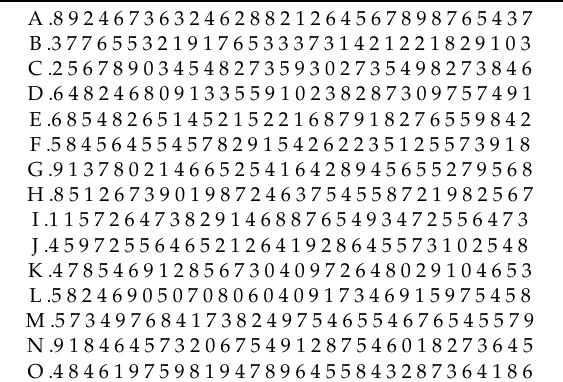
Table A2. In the following 15 lines of numbers, there are 80 groups of adjacent numbers that add up to 10. Underline each group of numbers that meet the requirements, such as 2357 64 389 82 26 91